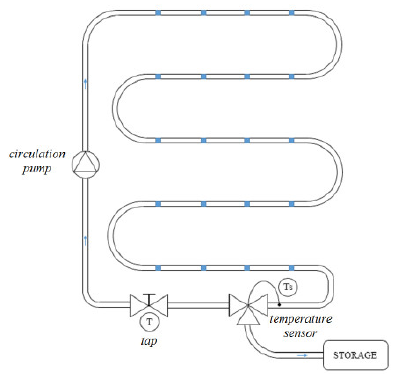
Figure 22. Schematic view of a heat recovery coil circuit with marked PV cells [108].